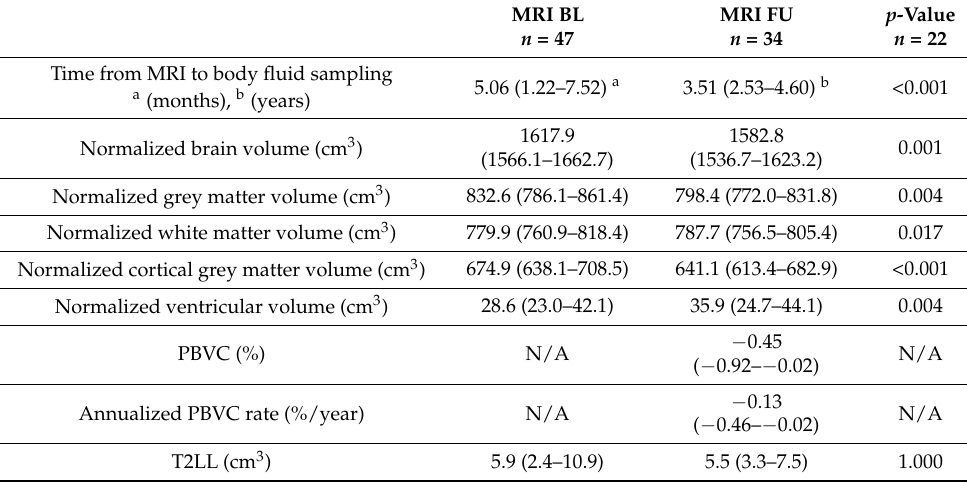
Table 3. MRI metrics of MS patients at baseline and